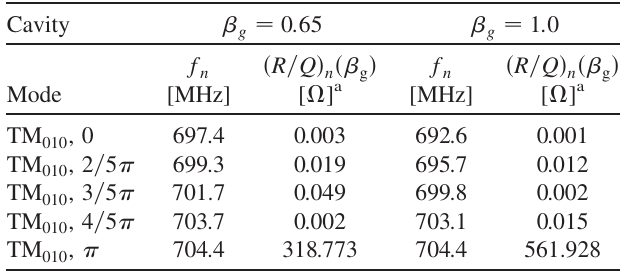
passband modes— SUPERFISH results. 010